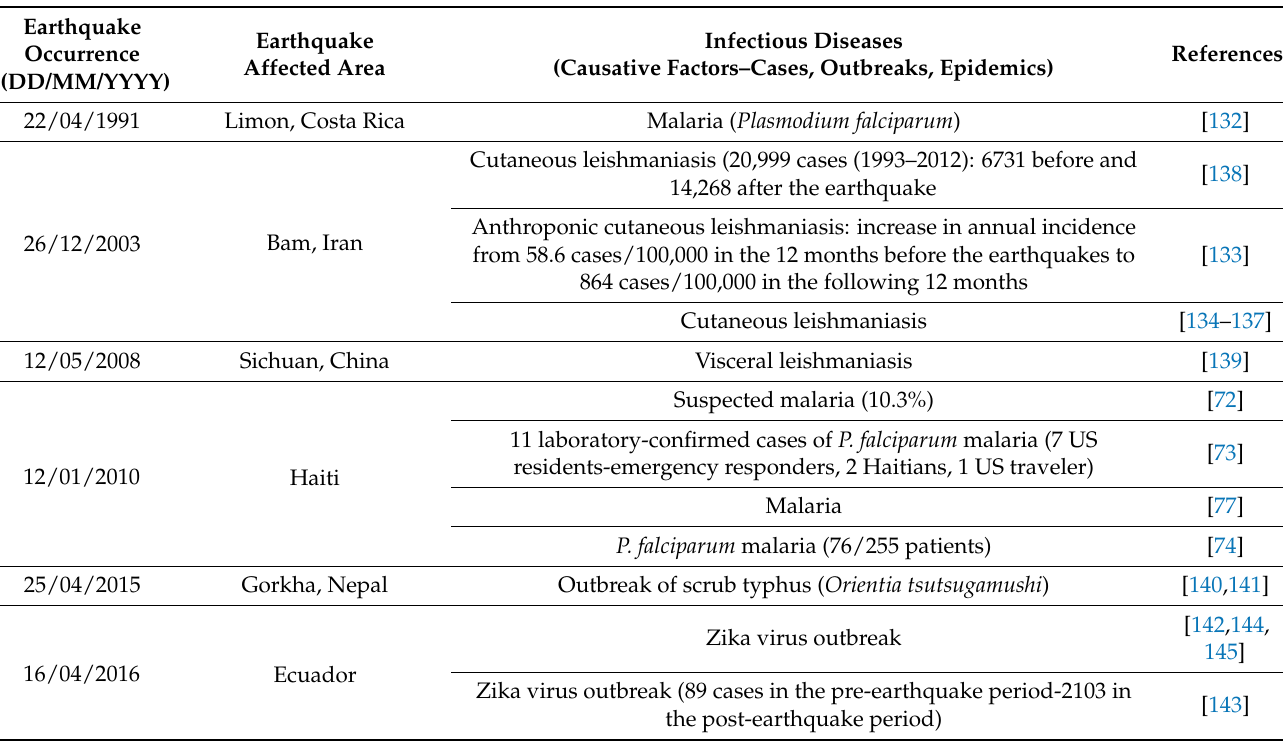
Table 4. Vector-borne infectious diseases transmitted during the post-earthquake period in earthquake-affected